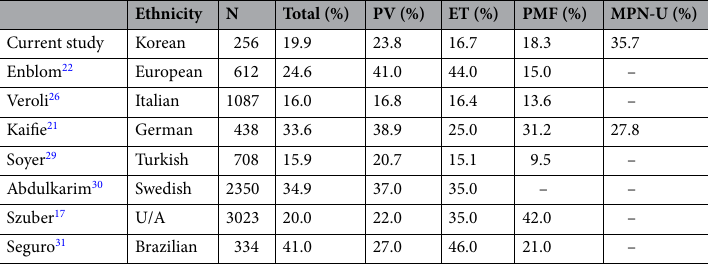
Table 3. Comparison of thrombosis before diagnosis of MPN.